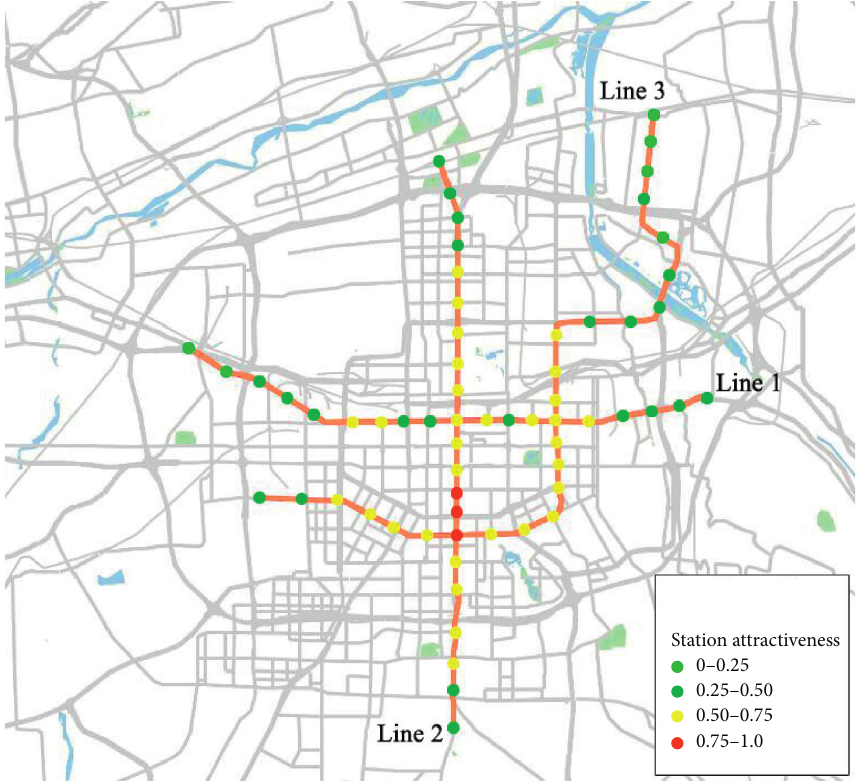
Figure 3: Calculated station attractiveness of urban rail